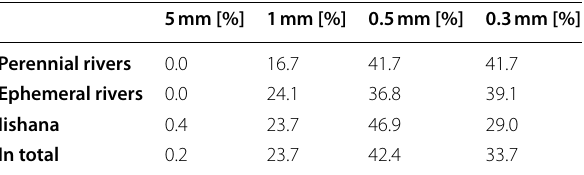
Table 1 Particle size of found microplastics, differentiated between perennial rivers, ephemeral rivers and the Iishana